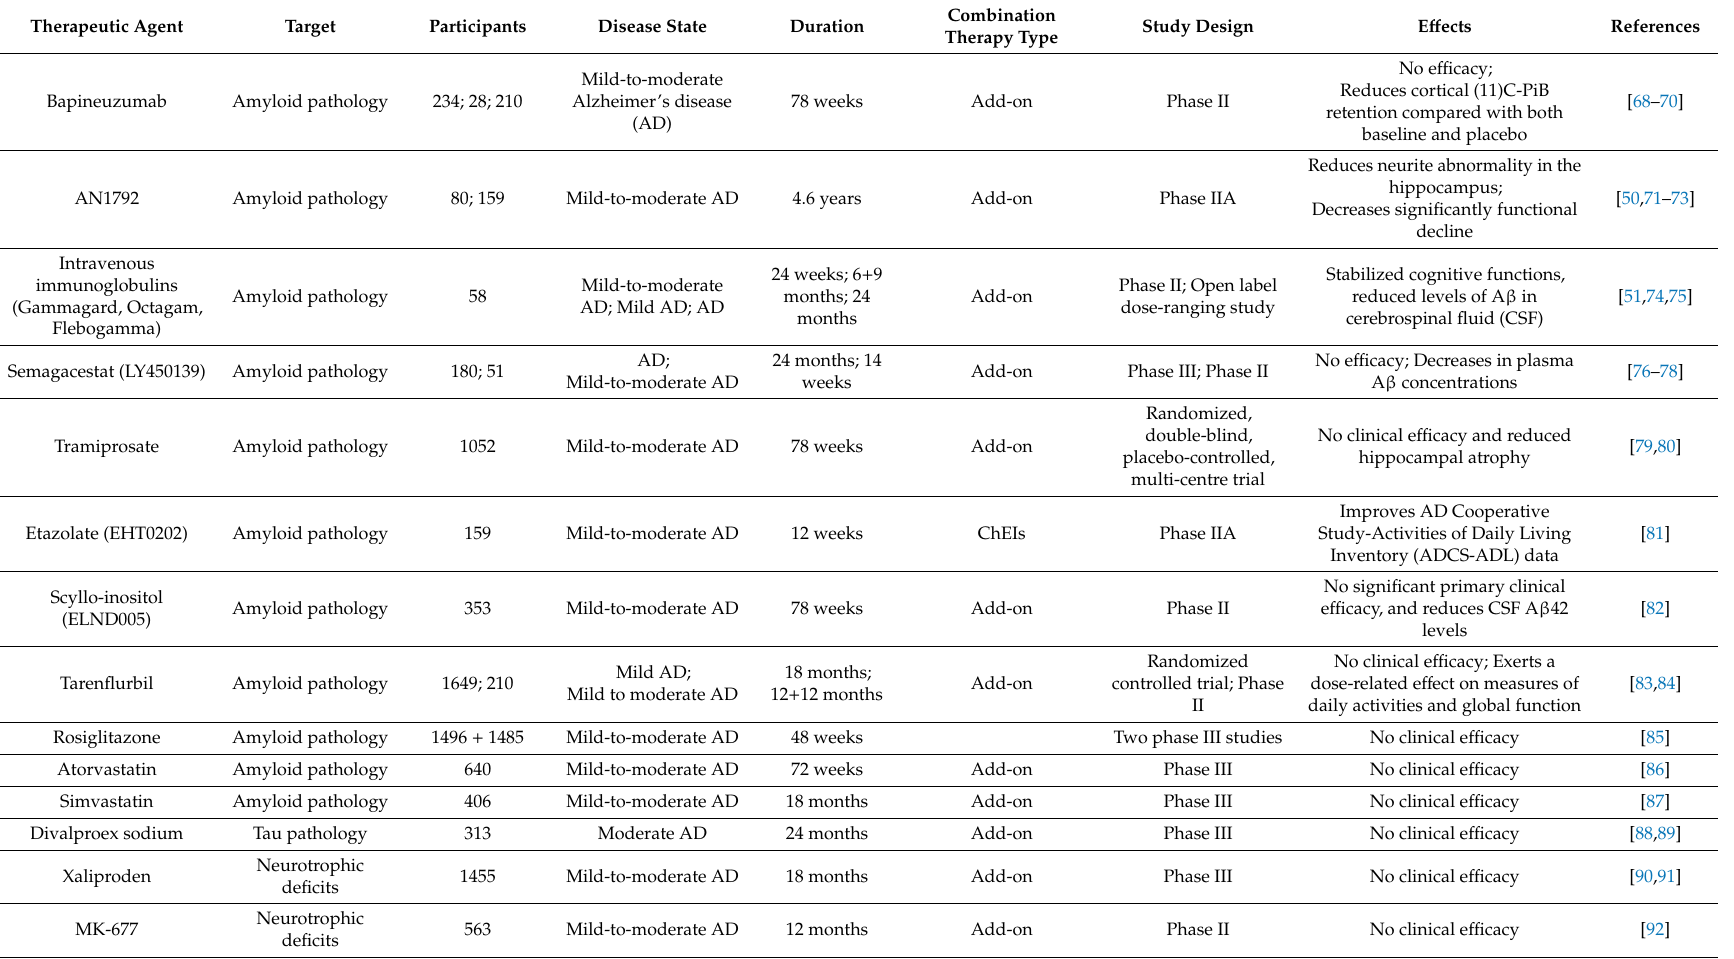
Table 2. Clinical studies with agents targeting di ff erent pathophysiological